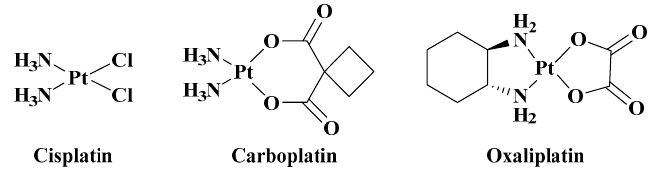
Figure 1. Structures of cisplatin, carboplatin and oxaliplatin.